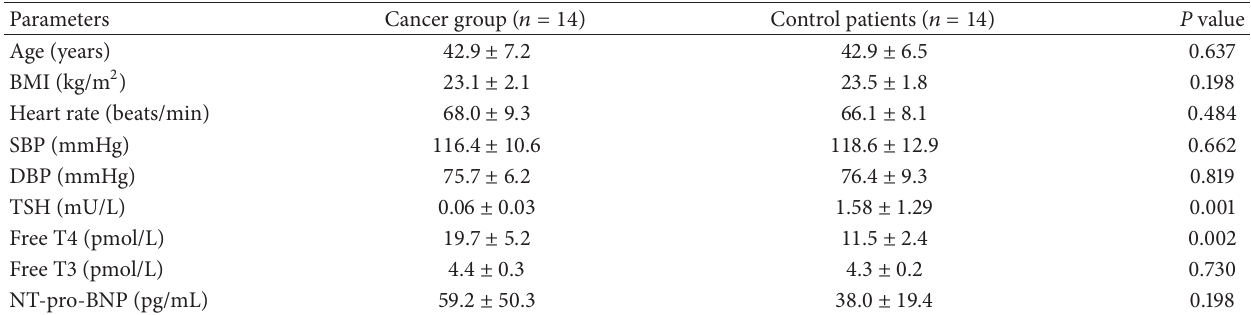
Table 2: Clinical and laboratory characteristics of the control group and differentiated thyroid cancer patients receiving long-term (5 to 9 years) levothyroxine suppression therapy.